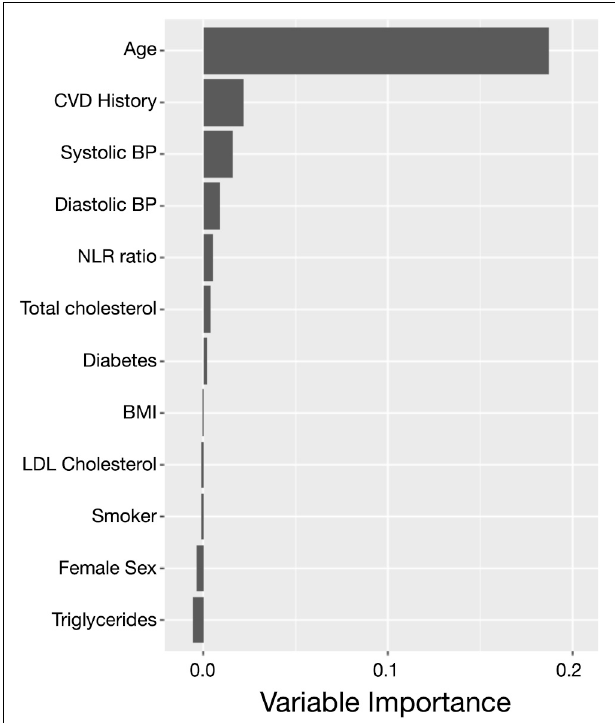
FIGURE 3 | The neutrophil to lymphocyte ratio plays an important role in incident dementia prediction. Ranked feature importance for random forest survival models for the prediction of incident dementia assigned a higher priority for the NLR (coded as continuous) over other clinical covariates. The highest priority was given to age, history of CVD, and hypertension, followed by the NLR and the remaining clinical and demographic covariates. Variable importance close to zero indicates the variable contributed nothing to predictive accuracy, and negative values indicate the predictive accuracy improved when the variable was misspecified and therefore was not informative. CVD, cardiovascular disease; FHS, Framingham Heart Study; NLR, neutrophil to lymphocyte